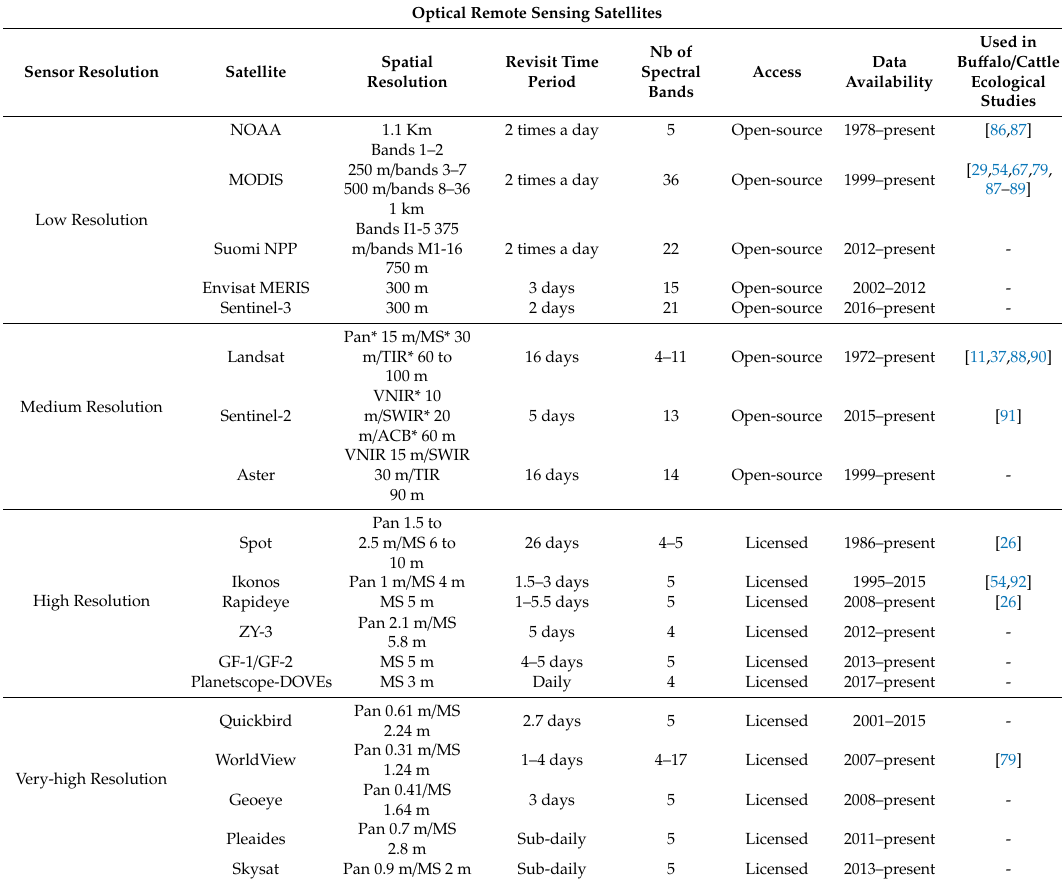
Table 1. Small subset of Earth observation satellite systems allowing data acquisition that can potentially be used in the field of animal movement